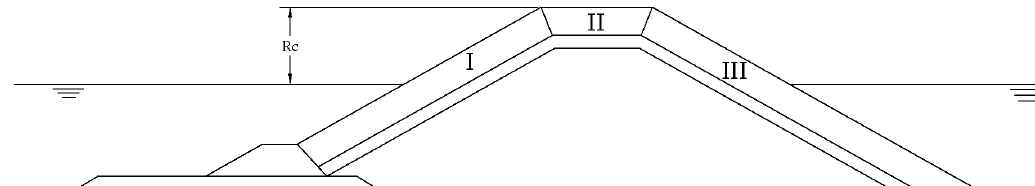
Figure 1. Division of armor layer in three parts.